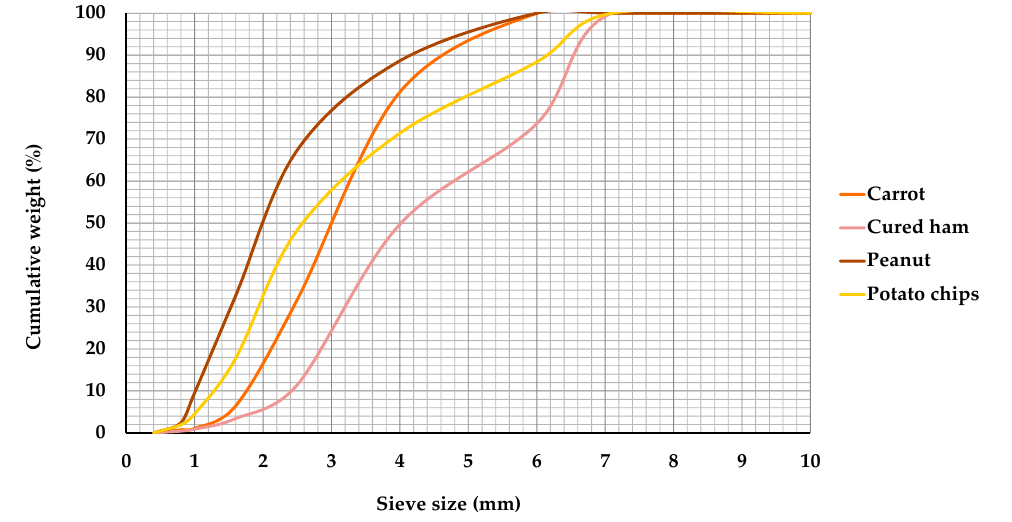
Figure 2. Particle size distribution curves of carrot, cured ham, peanut, and potato chip boluses collected at the end of in vivo mastication.